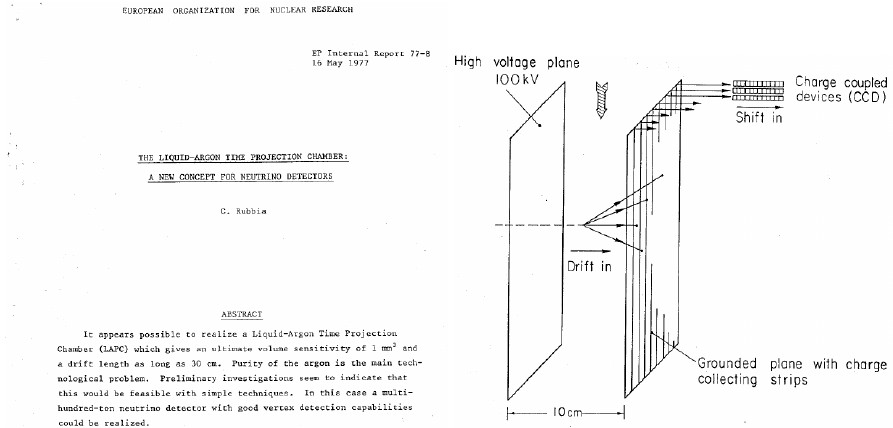
Figure 1. Very first concept of a LAr-TPC by Carlo Rubbia in his CERN internal note of